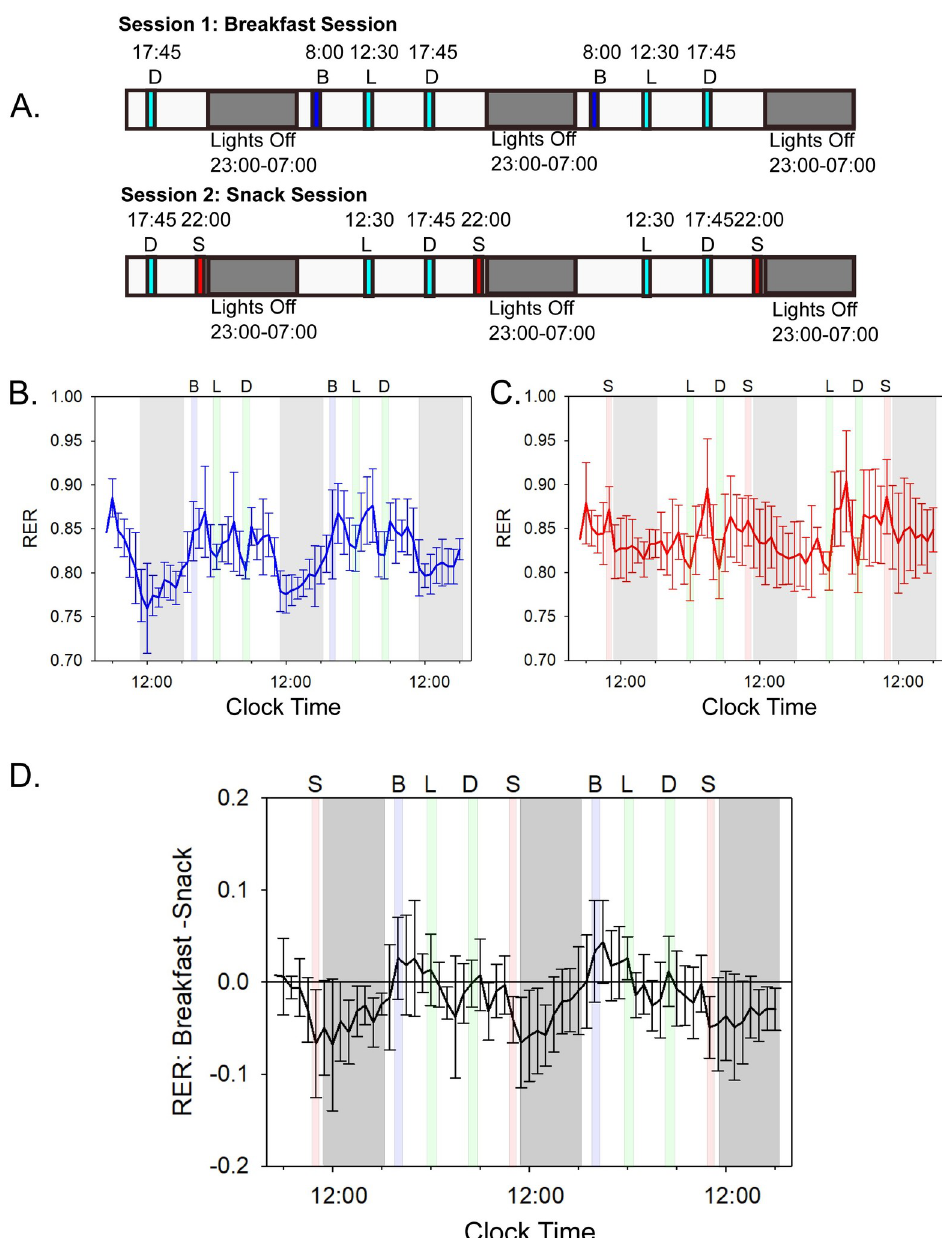
Fig 1. Chamber schedule and the impact of meal timing on subjects’ RERs. See S3 Fig and S2A Table and S1 Data for underlying data and analyses. (A) Protocol for "Breakfast" Session versus "Snack" Session. Subjects experienced two separate 56-h continuous sessions with constant metabolic monitoring by indirect calorimetry, each session lasting 56 h. The Breakfast Session included a breakfast (B), lunch (L), and dinner (D), while the Snack Session contained a lunch, dinner, and late-evening snack meal (S). The late-evening snacks were of equivalent caloric and nutritional value to the breakfast meals (approximately 700 kcal; see S1 Table for details). Note from S2 Fig that the daily phasing of sleep for the subjects prior to entry into the metabolic chamber was the same as the "lights-off" interval during the 56-h time course, so the subjects did not experience a phase shift of their daily cycle when they entered the experimental conditions. (B) Breakfast Session: blue line indicates the average hourly RER over the entire 56-h time course among all 6 subjects when a breakfast, lunch, and dinner were presented. Error bars are the standard deviation. Letters indicate time and type of meals, and gray shaded areas indicate the lights-off periods. Green shaded areas indicate meals that were given at the same time in both Breakfast and Snack Sessions (lunch and dinner). Blue shaded areas indicate when breakfast was given, and gray shading indicates the lights-off period. See S3 Fig for data of all subjects individually. (C) Snack Session: the red line indicates the average hourly RER over the entire 56-h time